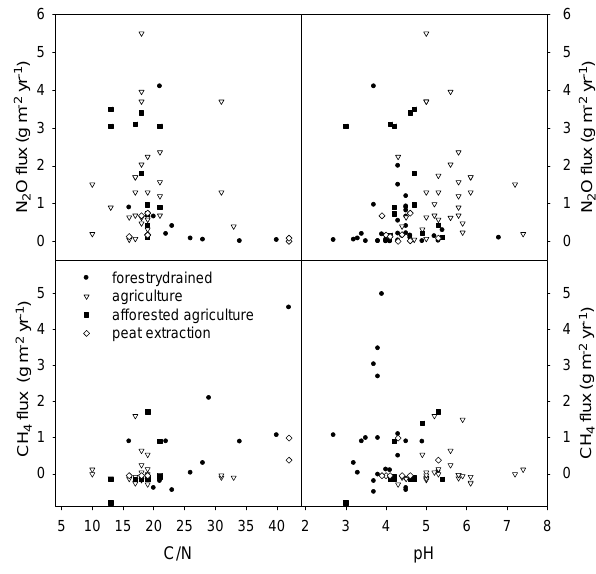
Fig. 2. Relationships between annual fluxes of N 2 O and CH 4 and soil C/N ratio and soil pH on drained peat soils (black circle=forestry drained, open triangle=agriculture, black square=afforested agricultural soils, open diamond=peat extrac- tion